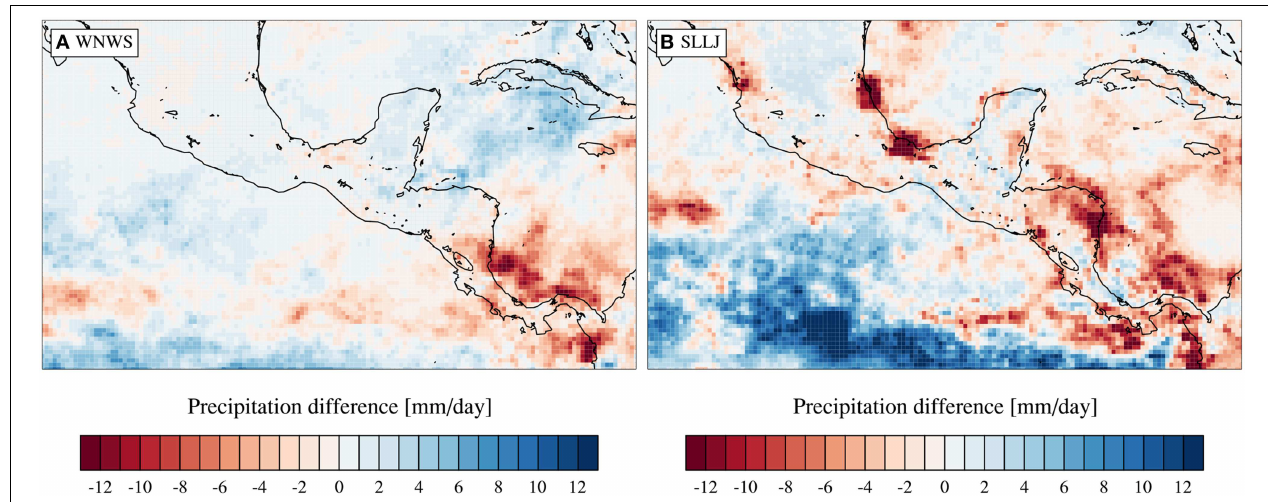
FIGURE 11 | Precipitation difference between warm and cold ENSO phases for (A) WNWS and (B) SLLJ regimes. Composites for cold ENSO were subtracted from composites for warm